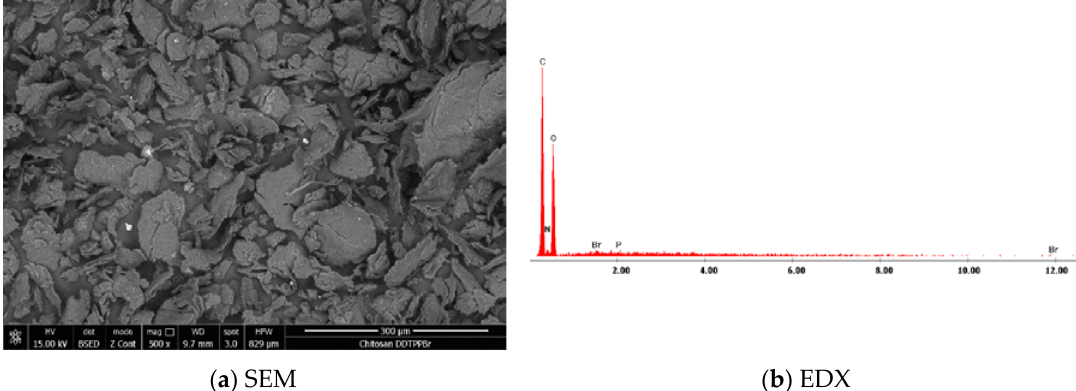
Figure 2. Scanning electron microscopy of new produced adsorbent material: ( a ) SEM and ( b ) X-ray energy dispersion — EDX.